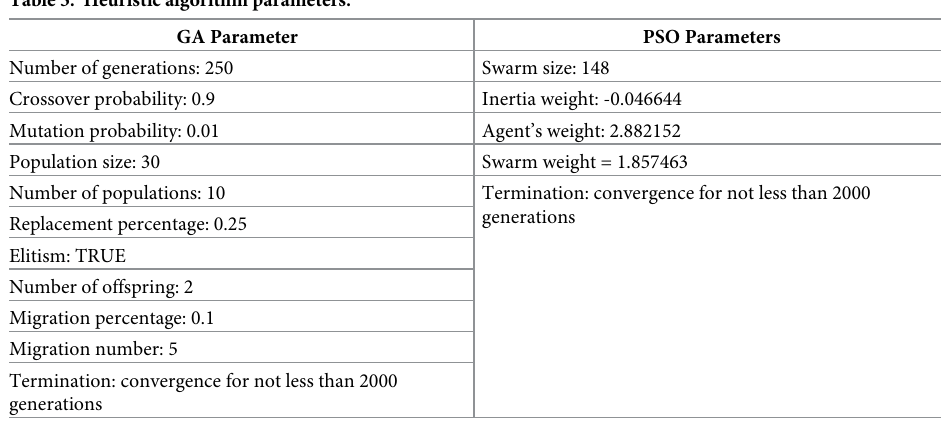
Table 3. Heuristic algorithm parameters.